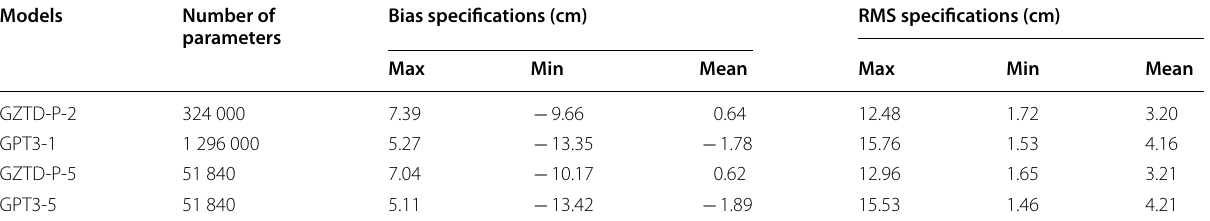
Table 4 The performance of the GZTD-P model and GPT3 model with different resolutions in the ZTD vertical interpolation of radiosonde data Models